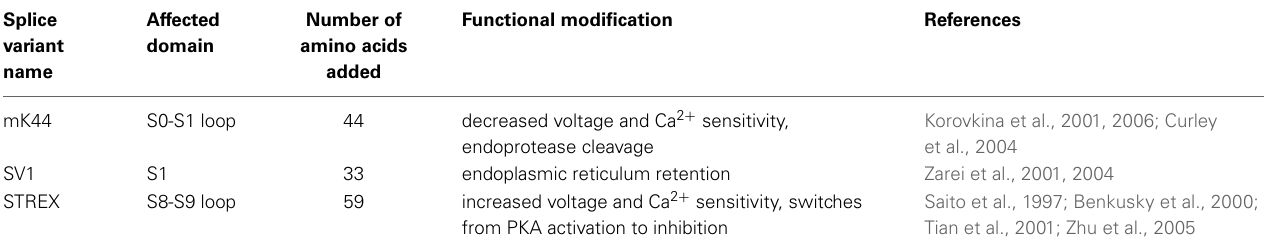
Table 1 | BK Ca channel splice variants expressed in the